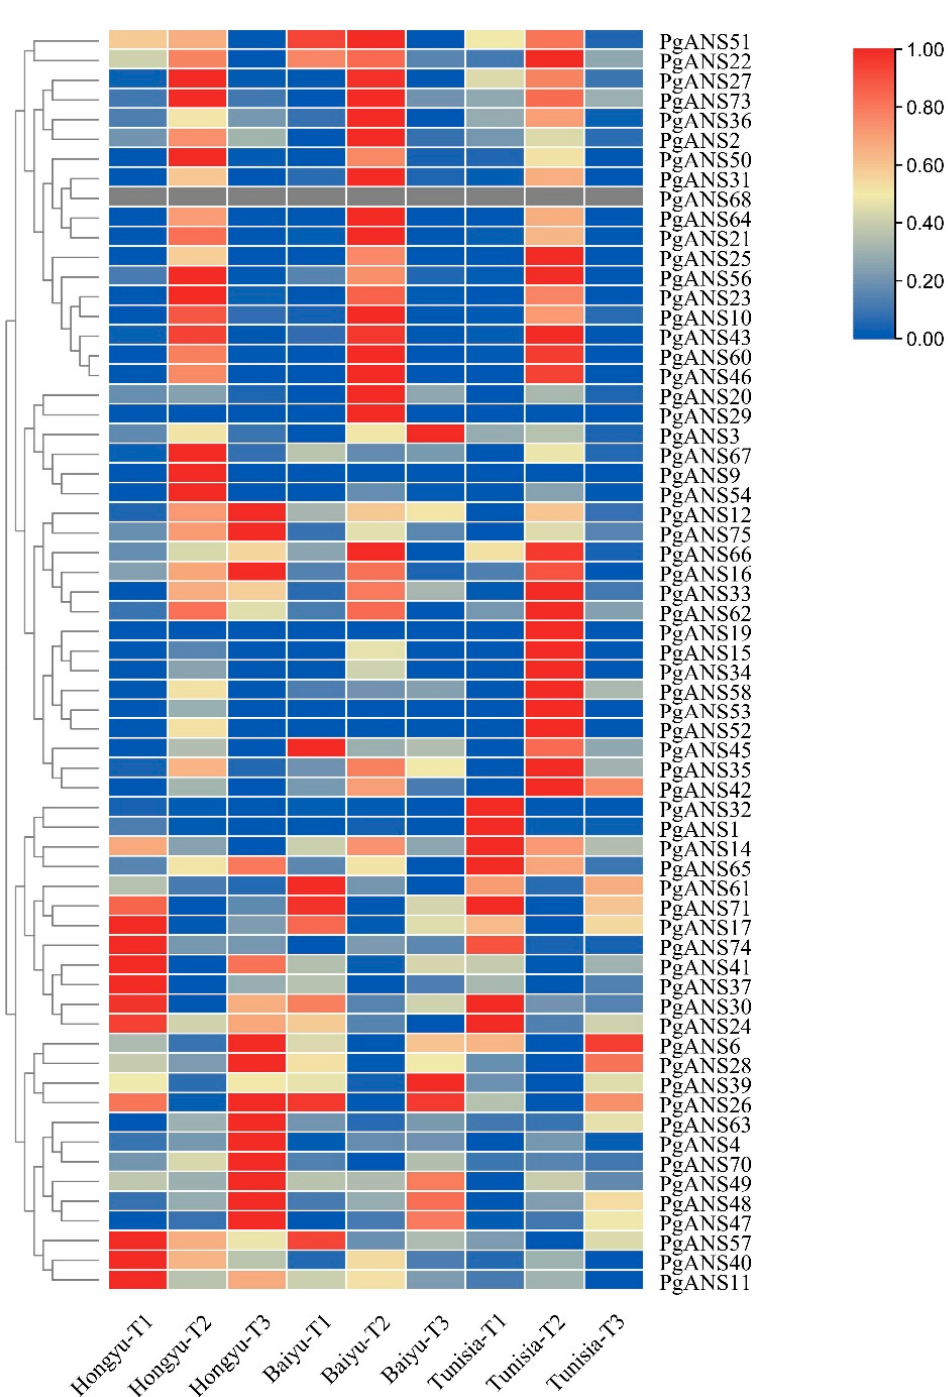
PgANS40 and PgANS11 were expressed at the highest levels in the red variety, ‘Hongyushizi’. PgANS51 , PgANS22 , PgANS45 , PgANS61 and PgANS26 were expressed at the highest levels in ‘Baiyushizi’. Additionally, PgANS32 , PgANS1 , PgANS14 and PgANS65 had the highest expression levels in